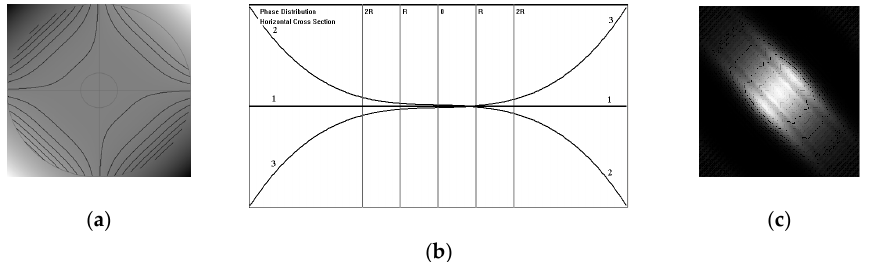
Figure 2. Phase specification by polynomial No. 5 (third-order astigmatism). Phase surface ( a ) and corresponding amplitude distribution of the beam passed path of 0.1 diffraction length ( c ) are shown by grayscale images. Cross-sections of the phase surface are presented in picture ( b ). Cross-section 1 was cut through the center of the beam, cross-section 2 corresponds to the cut shifted on the beam radius from the center in a positive direction of the y -axis, and number 3—to the cut shifted in a negative direction.